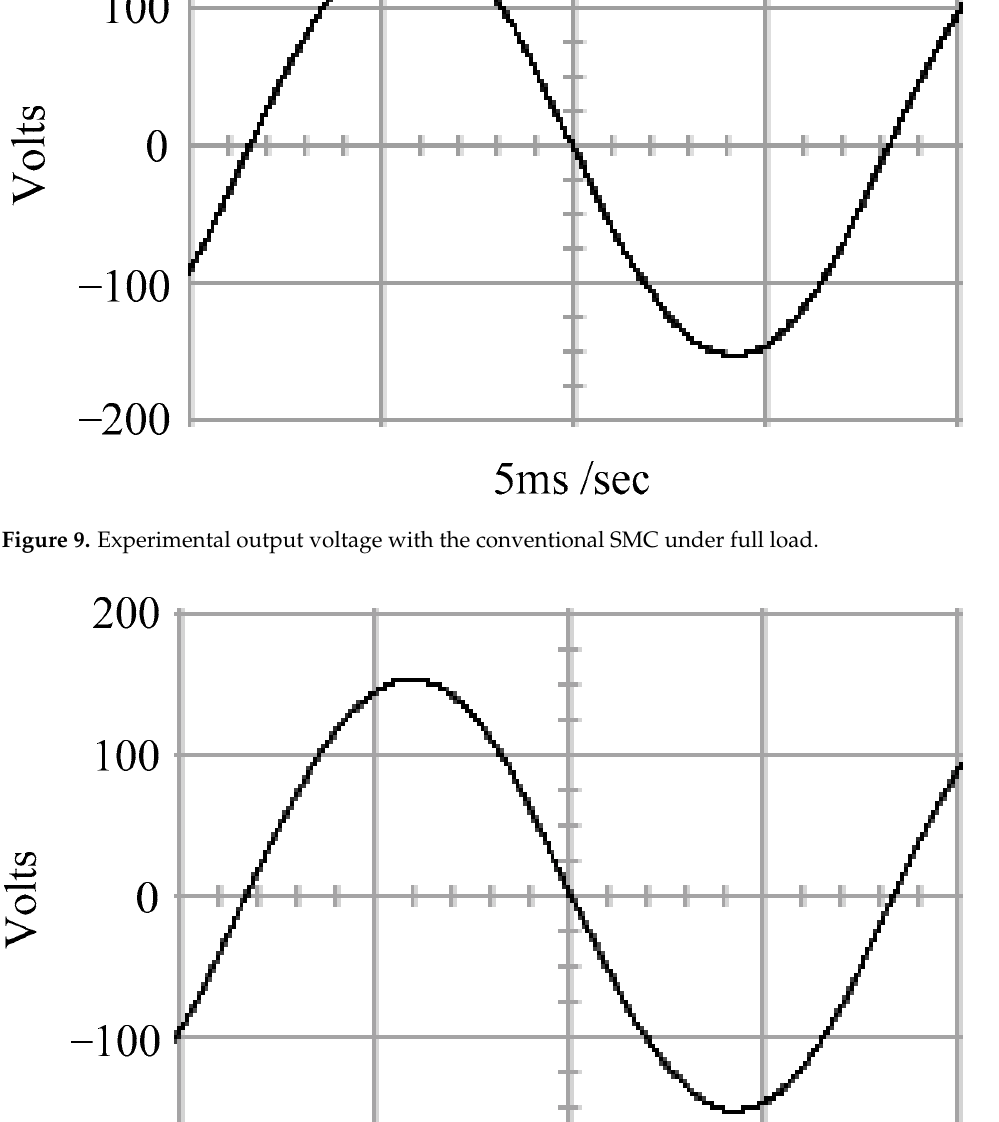
Figure 10. Experimental output voltage with the proposed technique under full load.